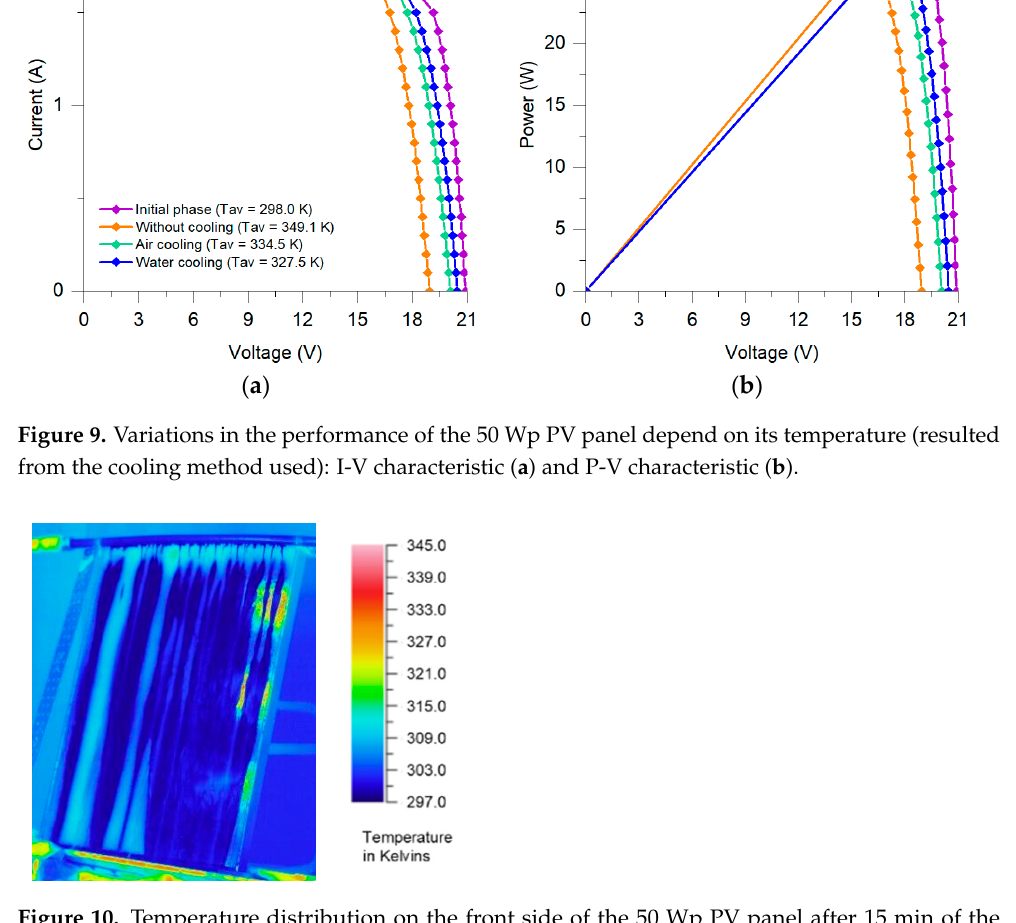
Figure 9. Variations in the performance of the 50 Wp PV panel depend on its temperature (resulted from the cooling method used): I-V characteristic ( a ) and P-V characteristic ( b ).